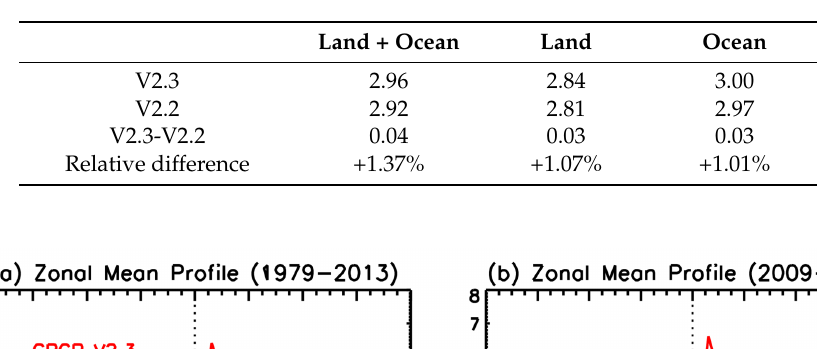
Table 6. Mean precipitation (P, mm day − 1 ) between 40 ◦ N and 40 ◦ S from GPCP V2.3 and V2.2 and their differences from 2009–2013.